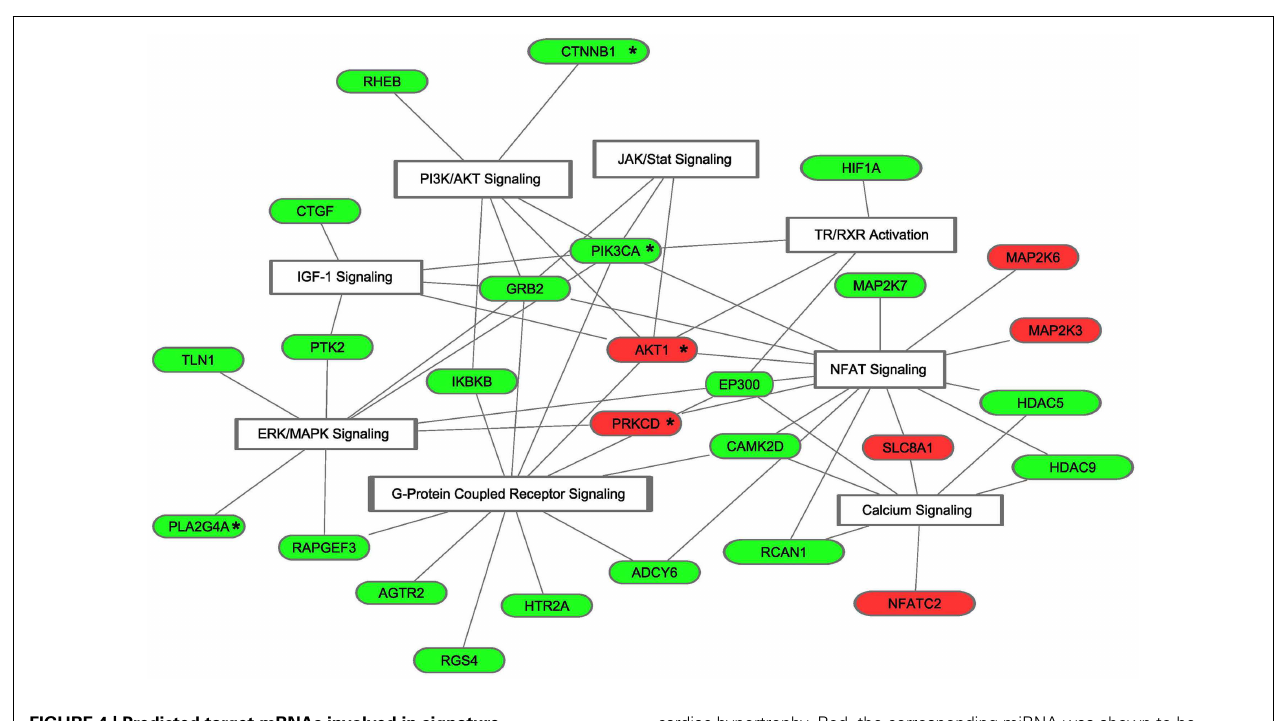
FIGURE 4 | Predicted target mRNAs involved in signature pathways of cardiac hypertrophy . Of the 2312 mRNAs that were targeted by either up- or downregulated miRNAs, 27 bona fide targets were found to be involved in cardiac hypertrophy.The presented molecules are members of at least one of the eight selected signature transduction pathways involved in the development of